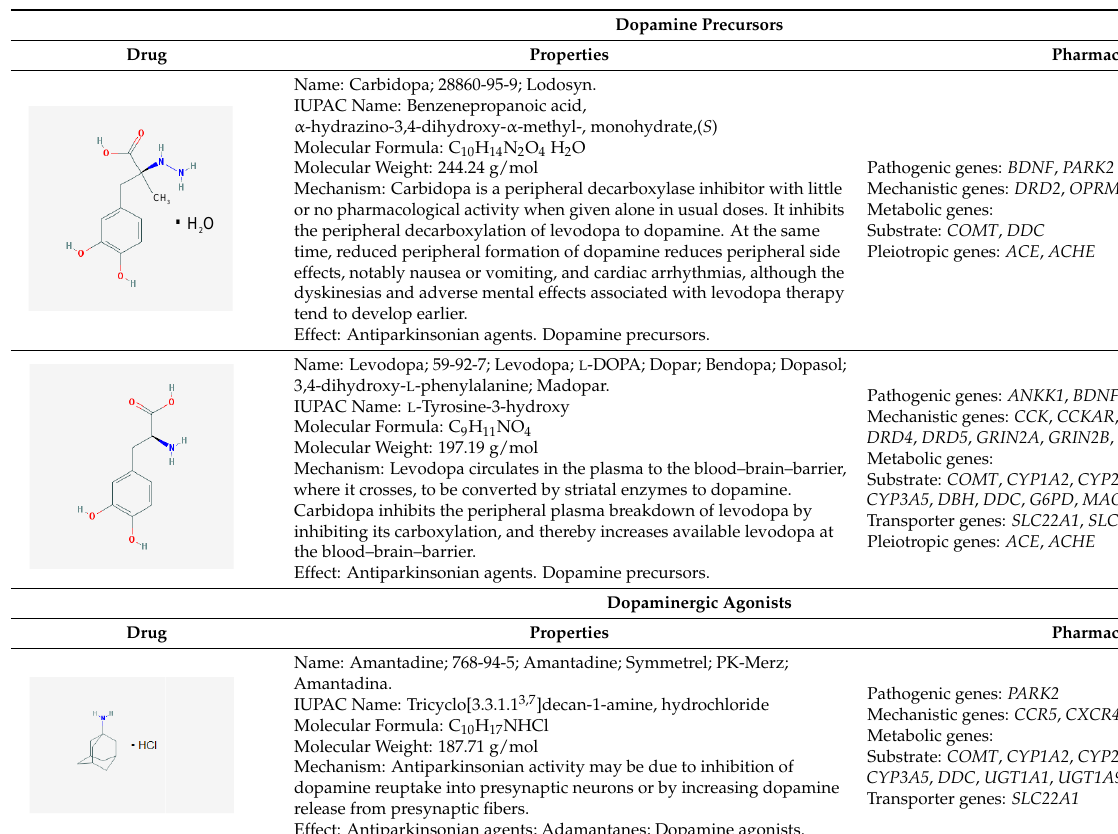
Table 1. Pharmacogenetics of antiparkinsonian drugs.